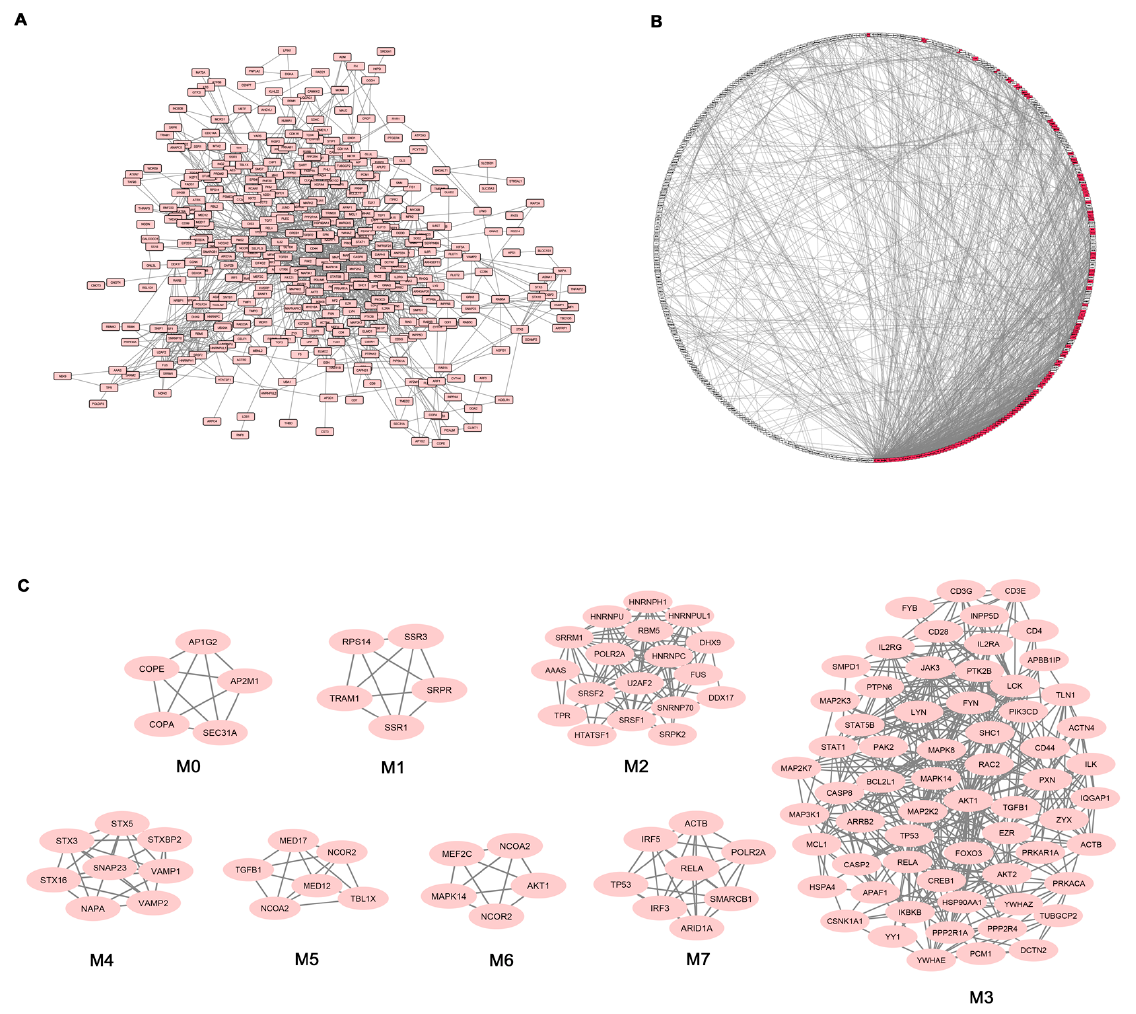
Figure 2. Network analysis of differentially expressed genes (DEGs) in AS patients. ( A ) Protein-protein interaction (PPI) network of DEGs; ( B ) Degree Sorted Circle Layout of the PPI network. Nodes are ordered around a circle based on their degree of connectivity (number of edges). Nodes belonging to modules are highlighted in red; ( C ) Modules originated from the interaction network.